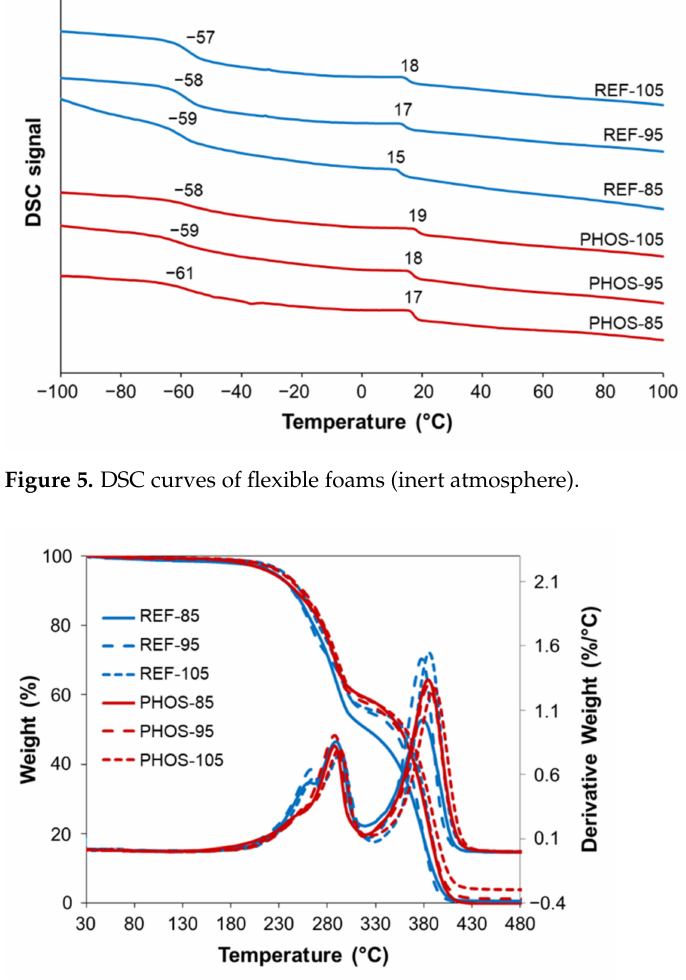
Figure 6. TGA and DTG curves of flexible foams (inert